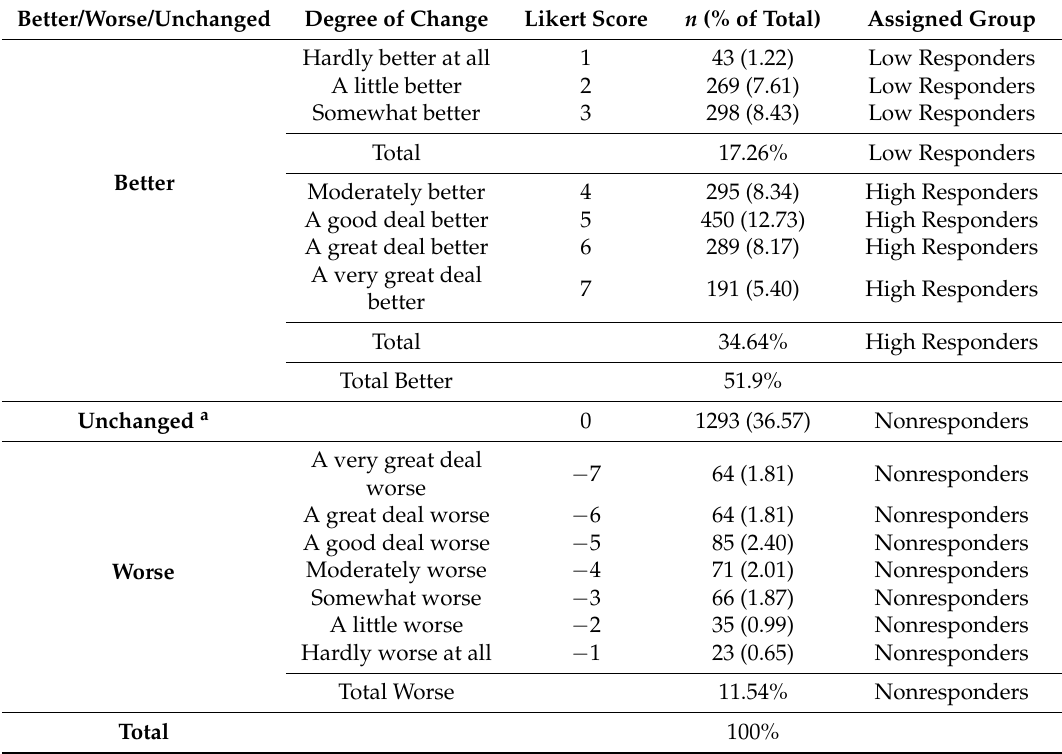
Table 3. Degree of change reported on global rating of change